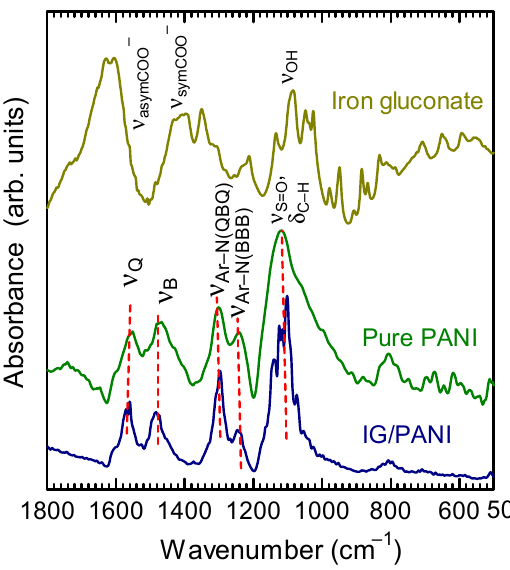
Figure 2. IR absorption spectrum of IG–PANI.